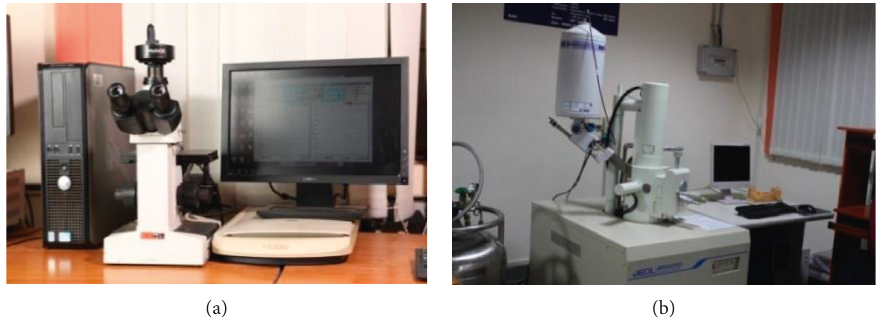
Figure 2: Microstructural test setup: (a) optical microscope and (b) scanning electron microscope.